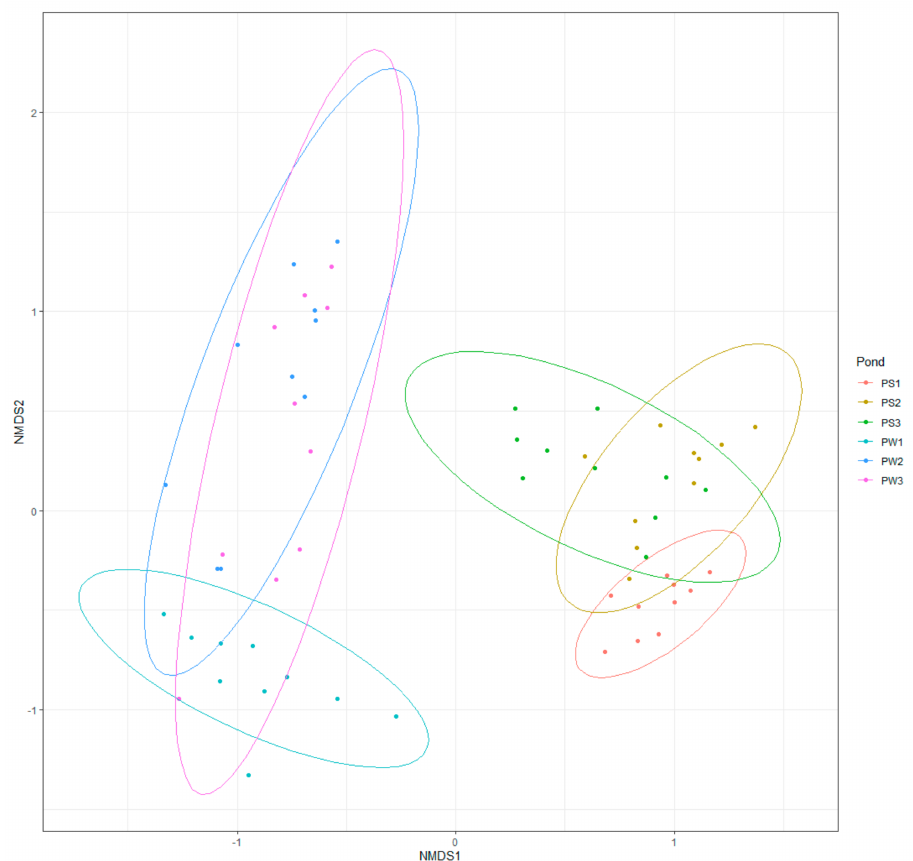
Figure 3. Non-metric Multi-dimensional Scaling (NMDS) analysis of major microbial communities (genus level) among milkfish pond water and sediment. PS: sediment. PW: water. 1: Control small milkfish pond. 2: Small milkfish pond with addition of MG. 3: Small milkfish pond with addition of MG and MG-degrading